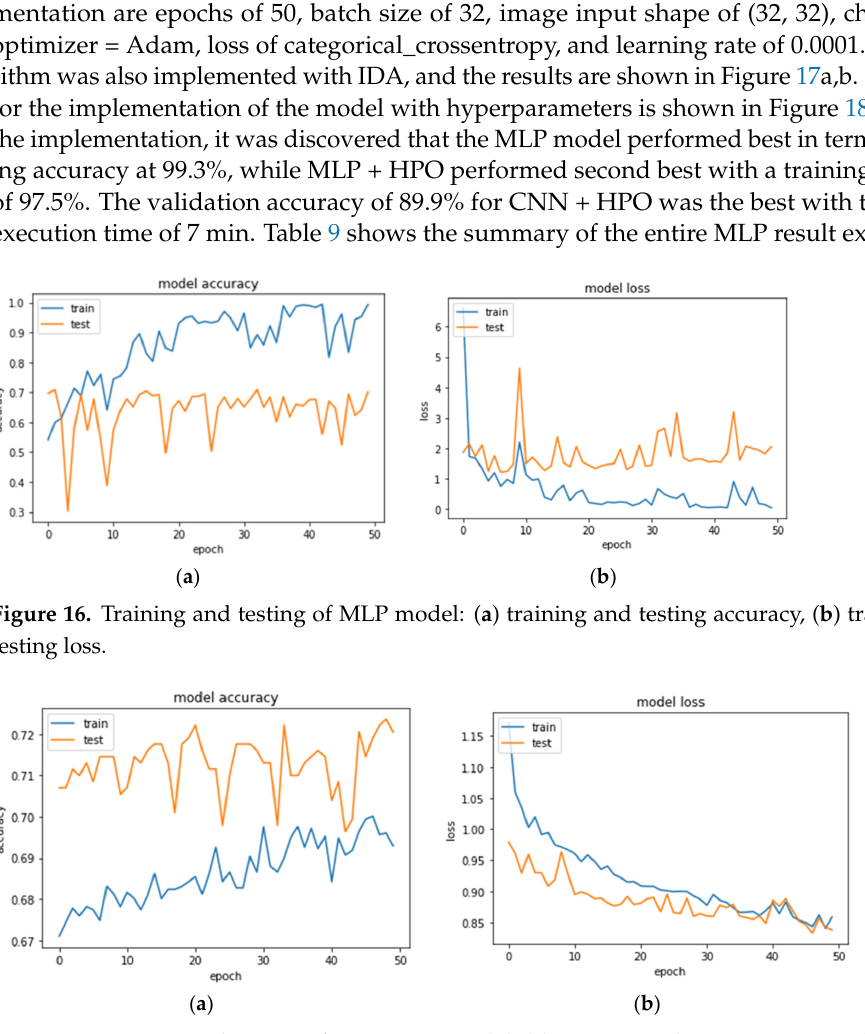
Table 9. Summary of MLP results.